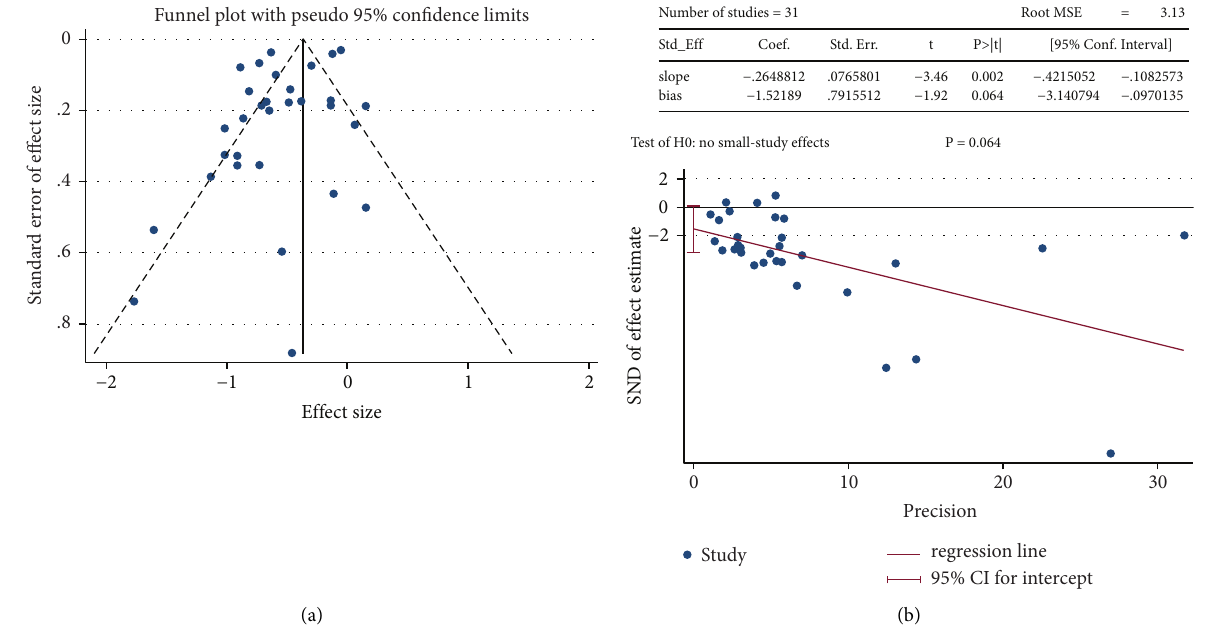
Figure 4: (a) Funnel plot of included studies. (b) Egger